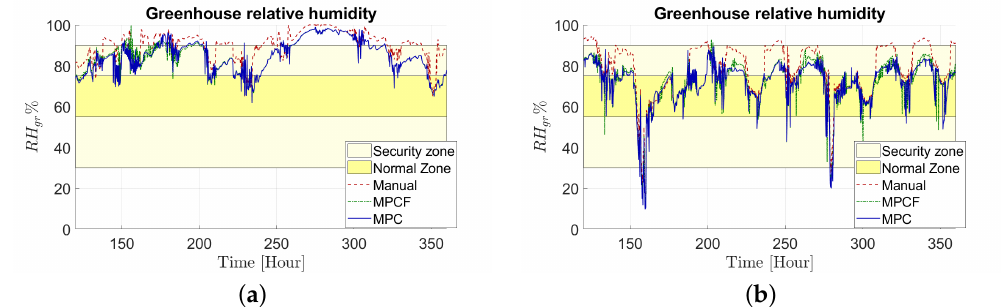
Figure 8. Relative humidity obtained inside the greenhouse during the simulations. Both results were compared with the values in the corresponding normal and security zones defined for this climatic variable. These simulation results were obtained using climate data from the winter and summer seasons. ( a ) Relative humidity inside the greenhouse RH gr when using winter data; ( b ) relative humidity inside the greenhouse RH gr when using summer